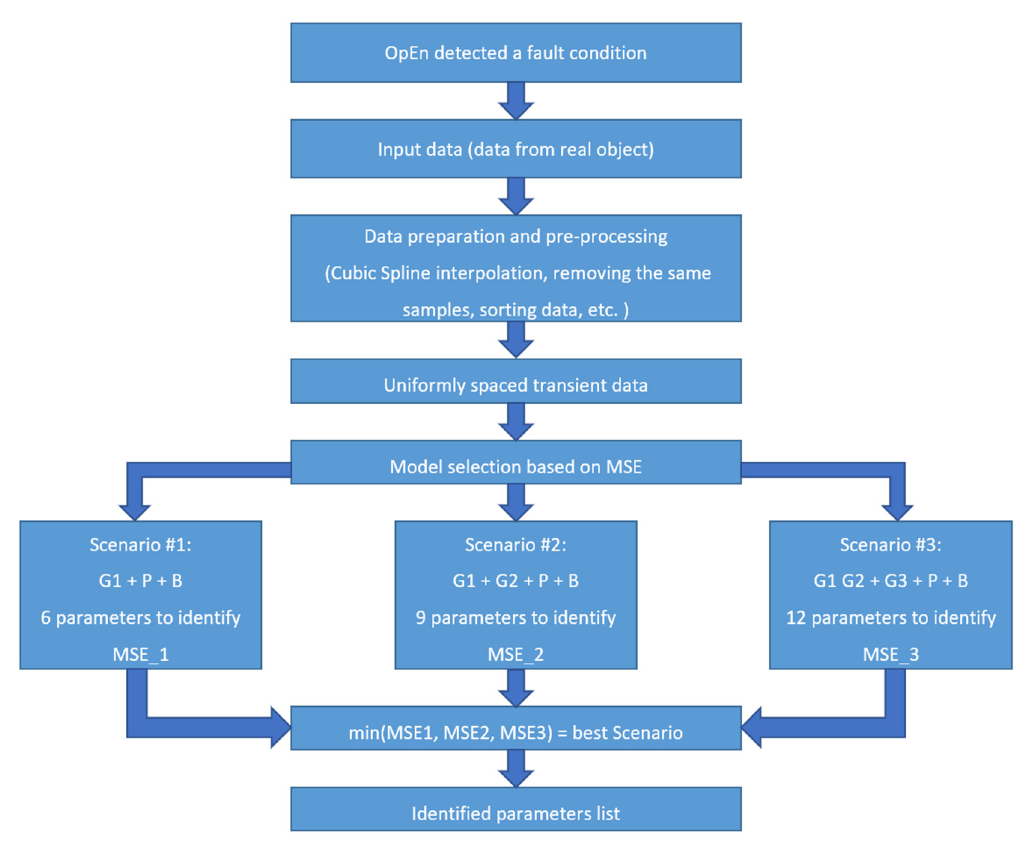
Figure 2. Flowchart of the MD3 method.